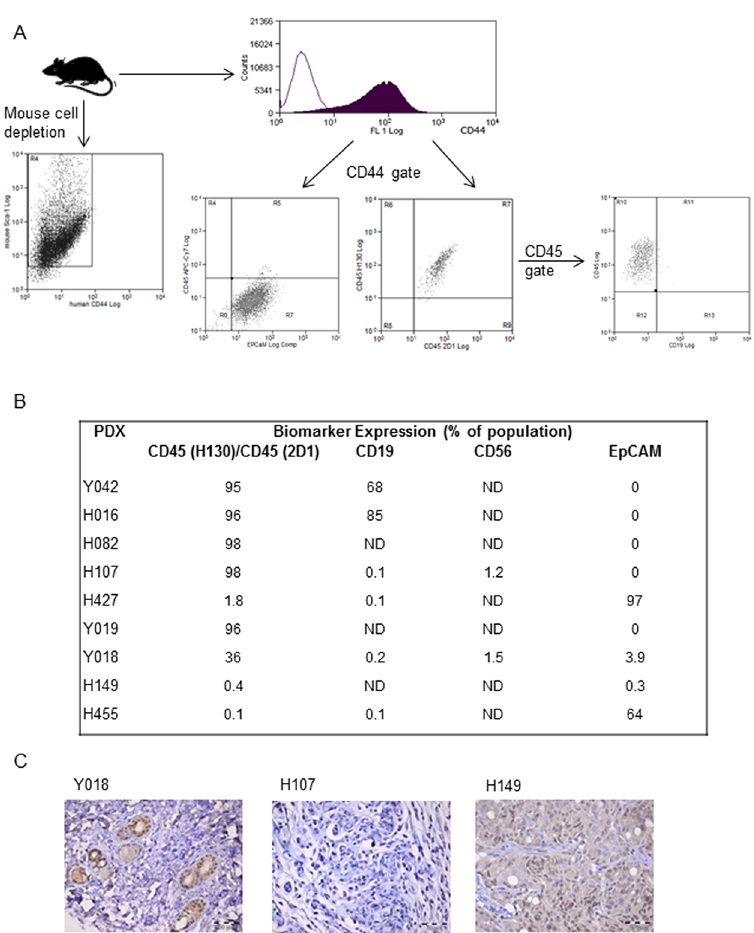
Fig 6. Flow cytometric gating strategyand analysis of PDX panel for epithelial and haematopoietic lineage markers.A . Seriallytransplantable PDX tumour were depleted of mouse cells before labellingwith humanspecific antibodiesto CD44, CD45, CD19, CD56 and EPCaM. B . Table of percentageof cells expressingspecific markers. LNCaPwas used as a positive control for EPCaM expressionand PC3 was used as a negativecontrol for CD45, CD19and CD56 expression. C . IHC of Chromogranin A expressionin PDX lines.